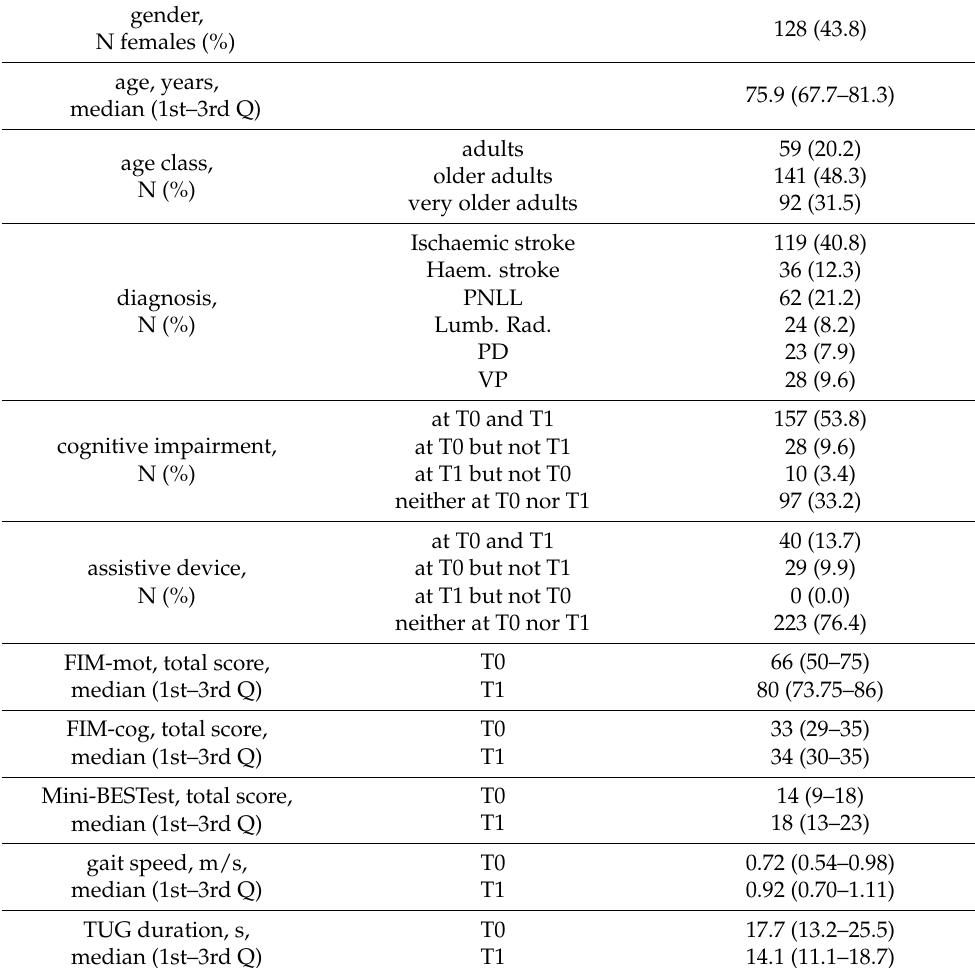
Table 1. Participants’ clinical